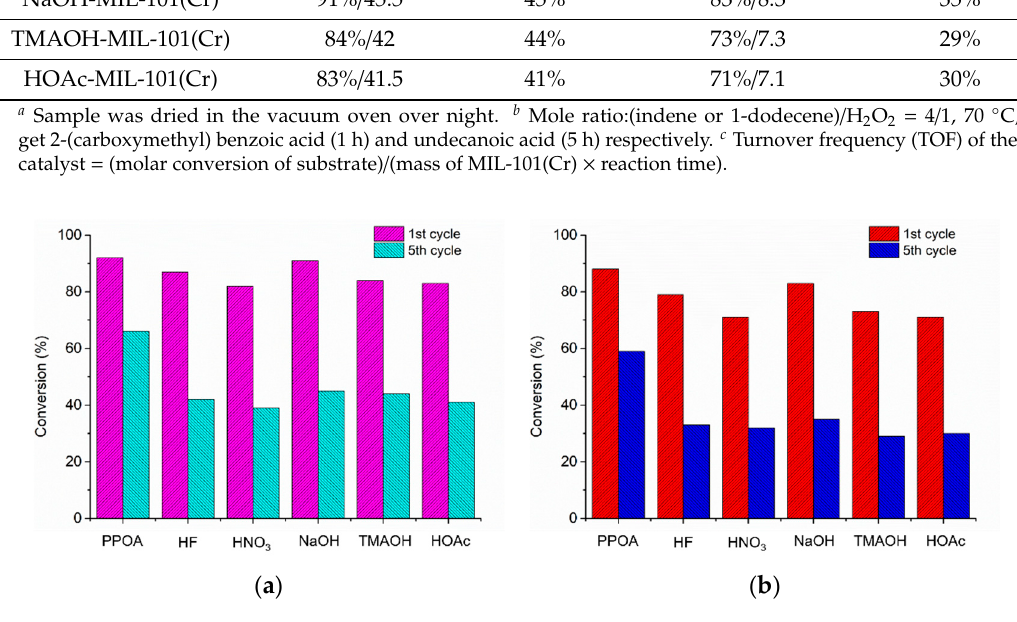
Figure 4. Comparison of the conversion of ( a ) indene and ( b ) 1-dodecene with MIL-101(Cr)s as catalysts for the first run and the fifth run.